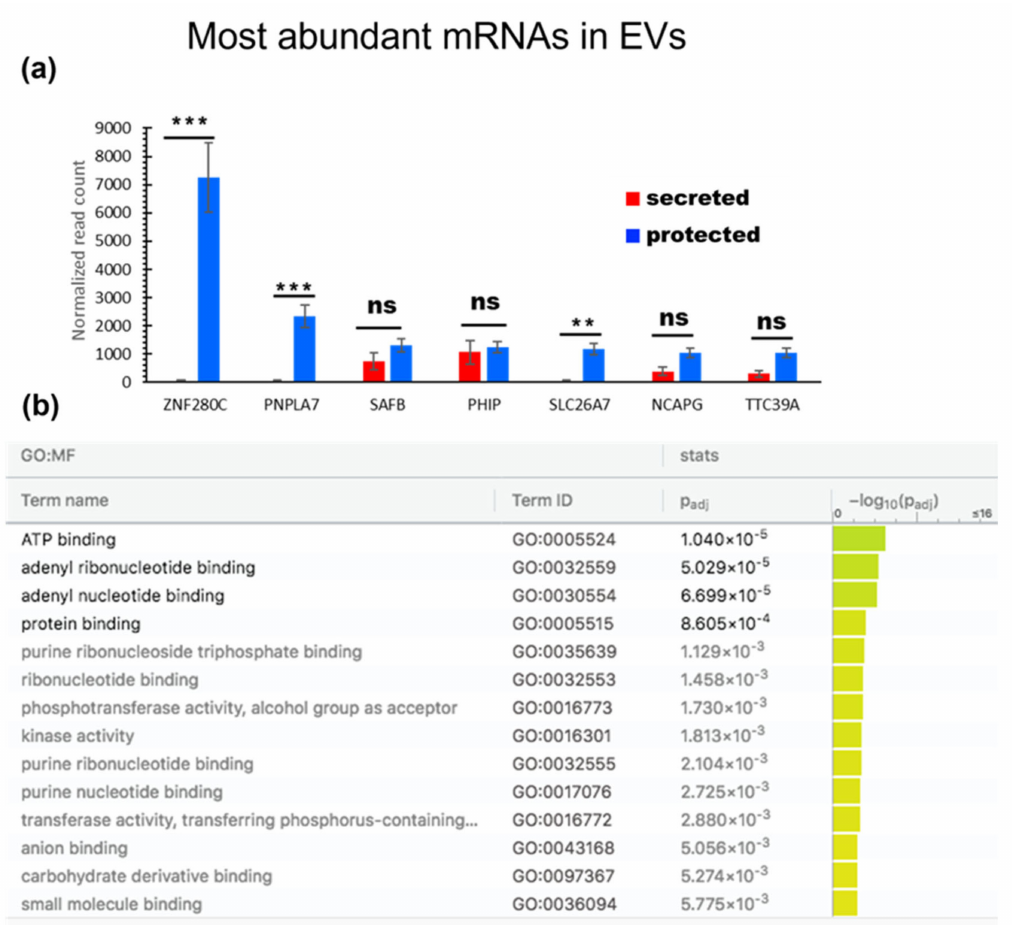
Figure 11. ( a ) Most abundant mRNA identified in the EVs. ( b ) GO annotations for the molecular function of the EV mRNA normalized value ≥ 10 from the g:profiler ordered